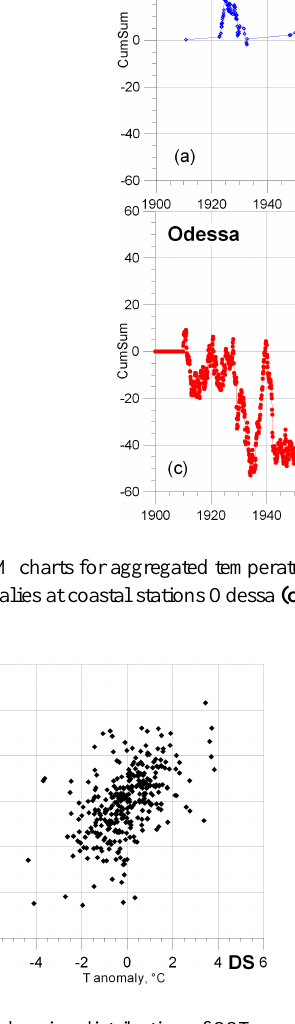
Fig. 9. A scatter plot showing distribution of SST anomalies on the Western shelf against SST anomalies in the deep